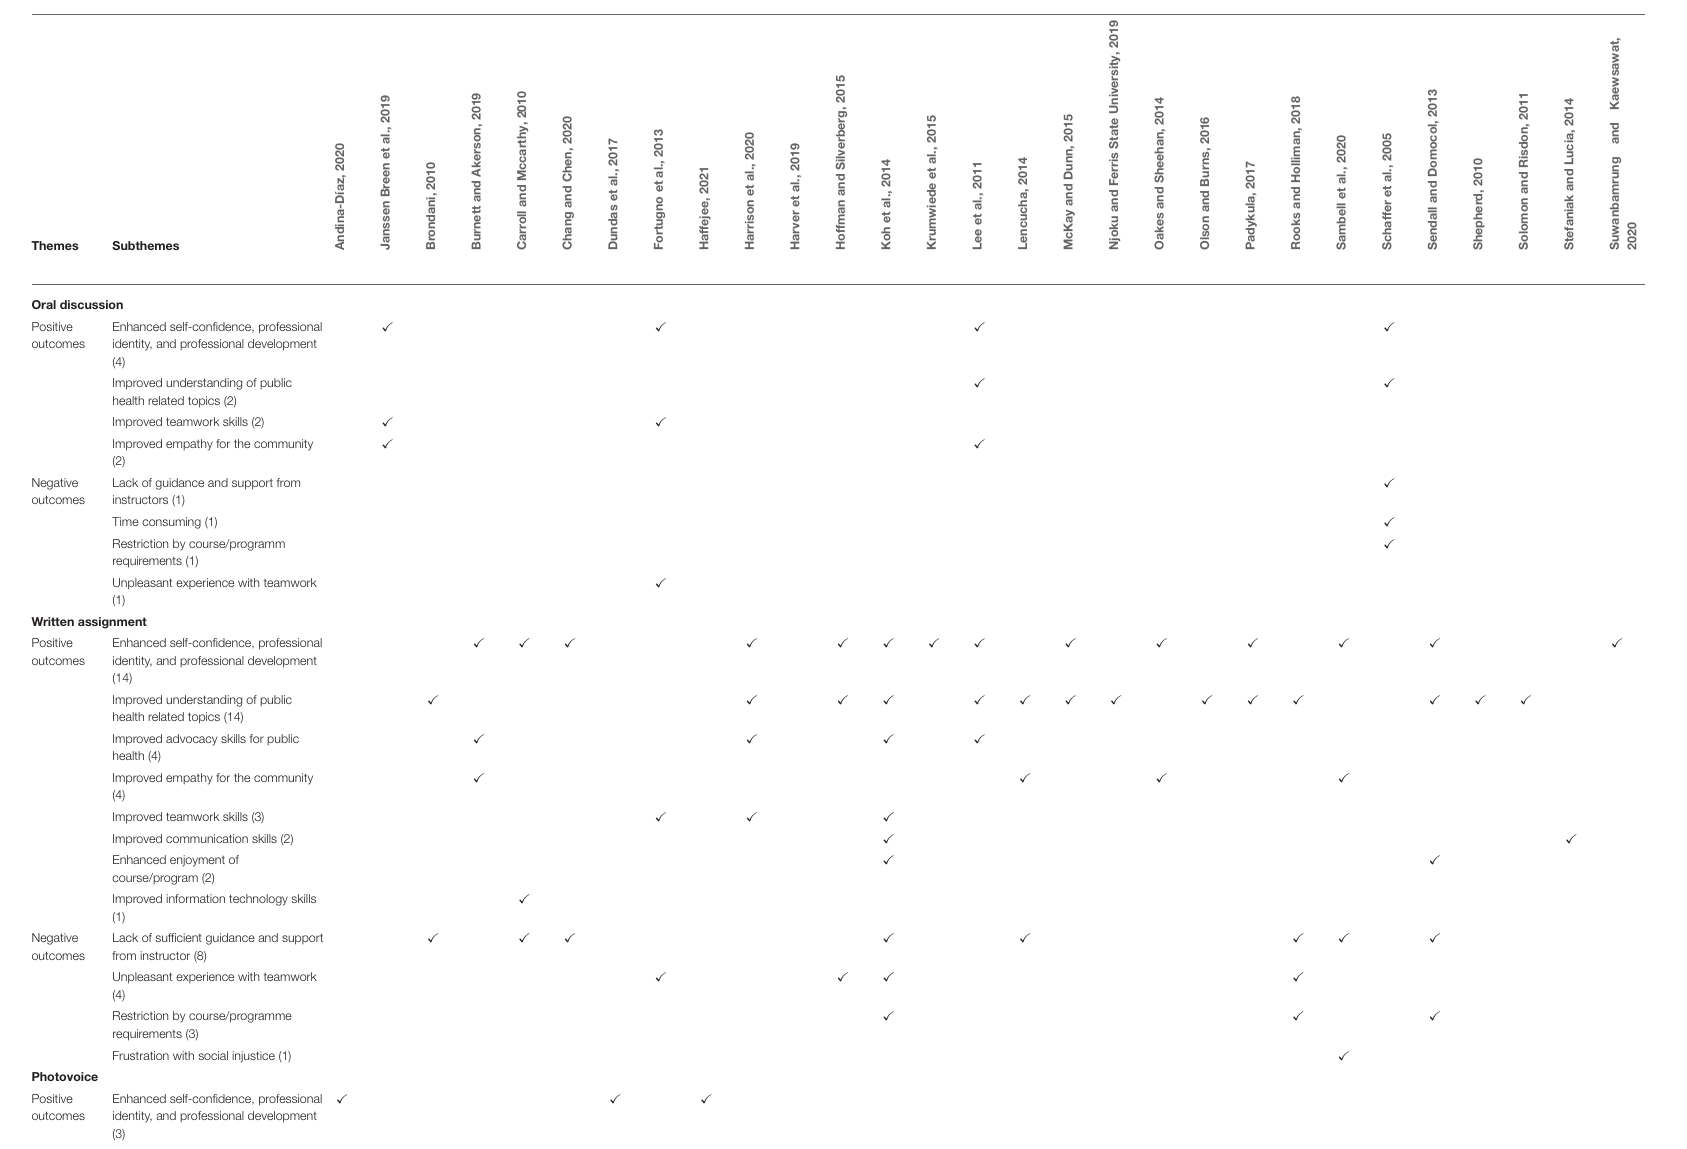
TABLE 3 | Themes and subthemes on the outcomes of self-reflection.